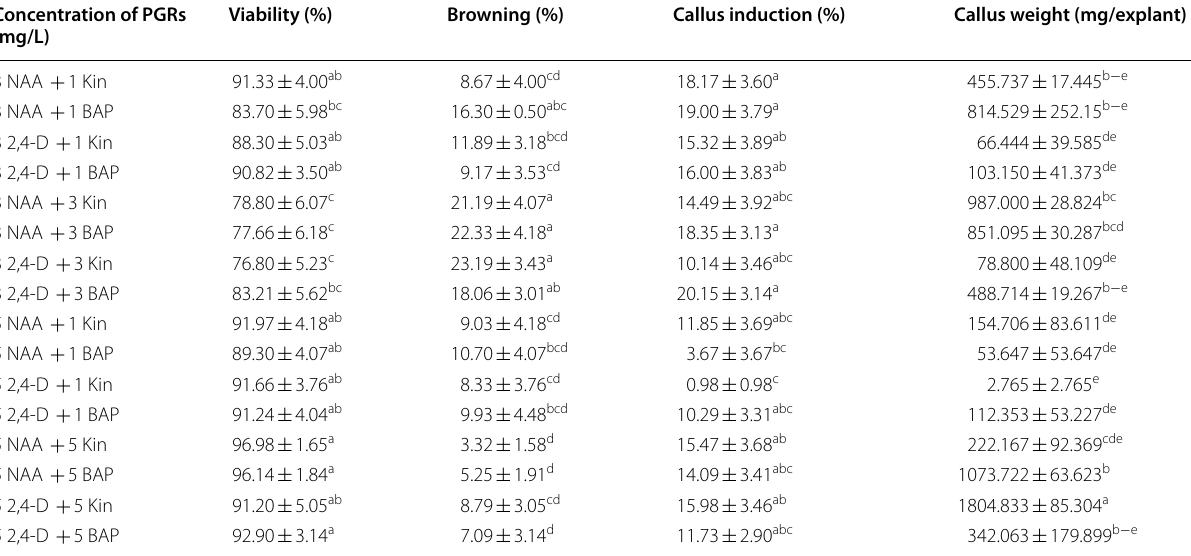
In each column, different letters indicate a significant difference ( P Experiment 2: the effect of benomyl inclusion in the culture